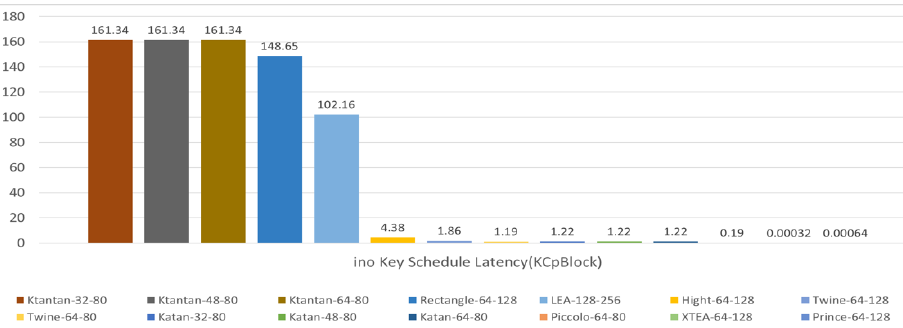
Figure 9. The 10 least speed latency in key schedule and 5 biggest in UNO.